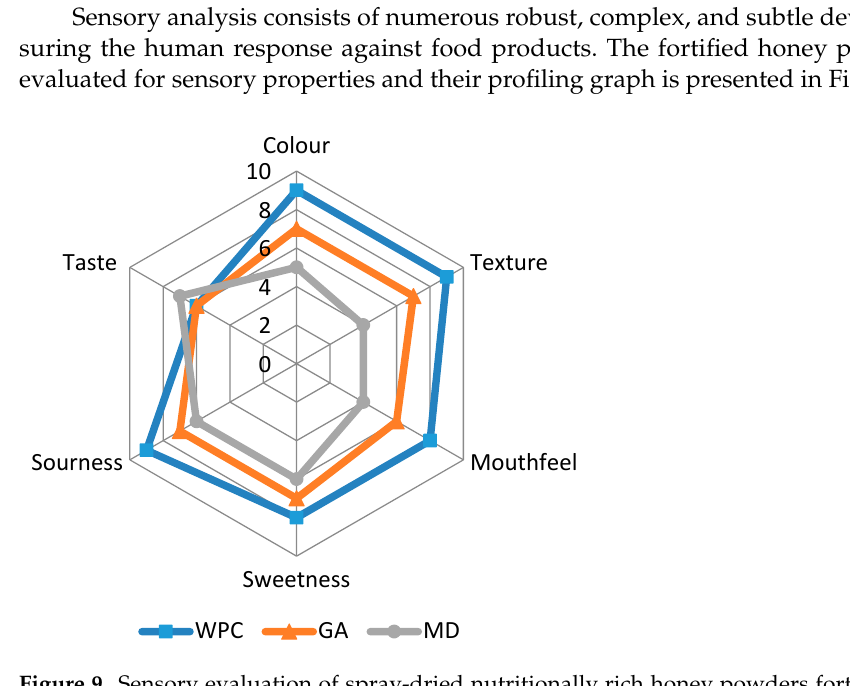
Figure 9. Sensory evaluation of spray-dried nutritionally rich honey powders fortified with maltodextrin (MD), gum arabic (GA), and whey protein concentrate (WPC) carrier agents.